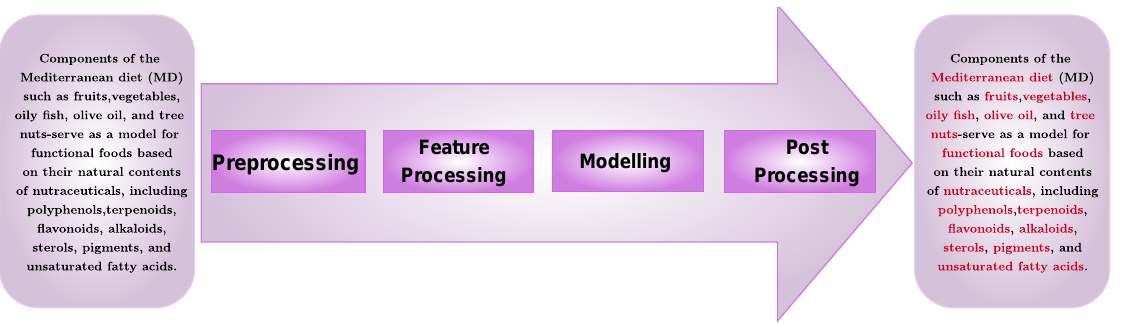
Figure 1. The main steps in designing a BioNER system (with an excerpt from PubMed abstract